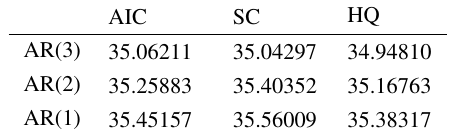
Fig. 3 ADF test with time term and intercept term after first-order difference. Table 1 AIC equivalence of different AR values